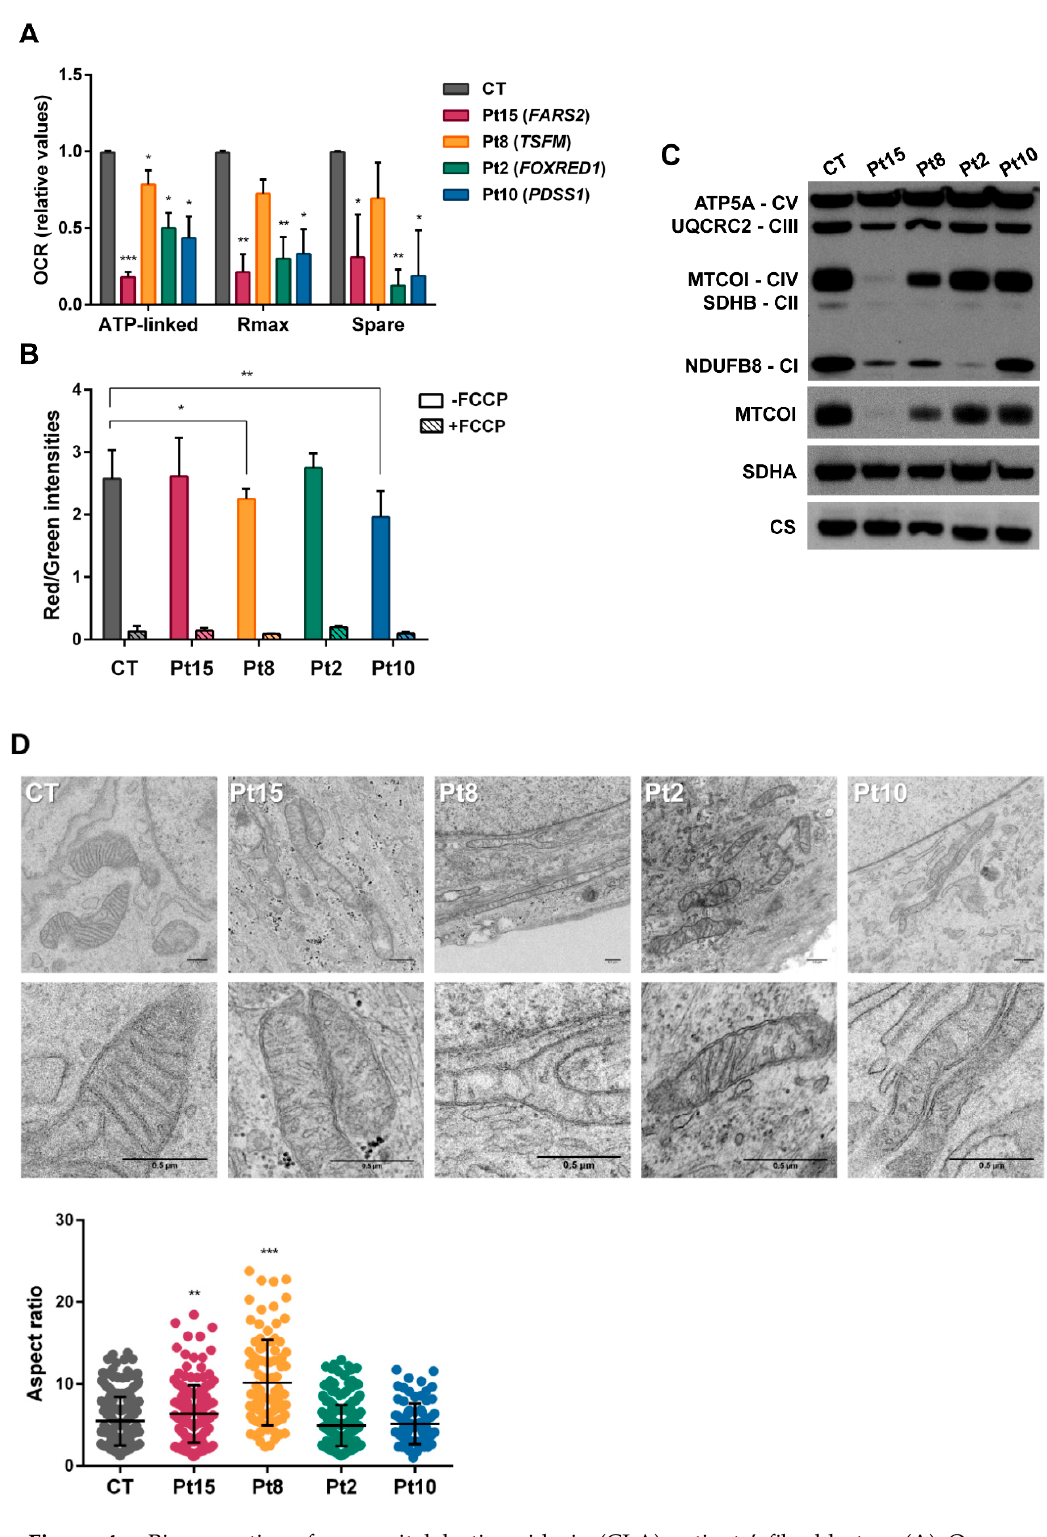
Figure 4. Bioenergetics of congenital lactic acidosis (CLA)-patients’ fibroblasts. ( A ) Oxygen consumption rates. The data shown are for ATP-production-dependent maximal respiration (Rmax) and spare capacity (spare). Results are expressed as fold over the control concentrations and are the mean ± SD of 3–5 wells from n = 2–3 independent experiments. Control values are the means of two di ff erent control cell lines. ( B ) Flow cytometry analysis of mitochondrial mass (Mitotracker green) and membrane potential (TMRM staining) in the absence / presence of carbonyl